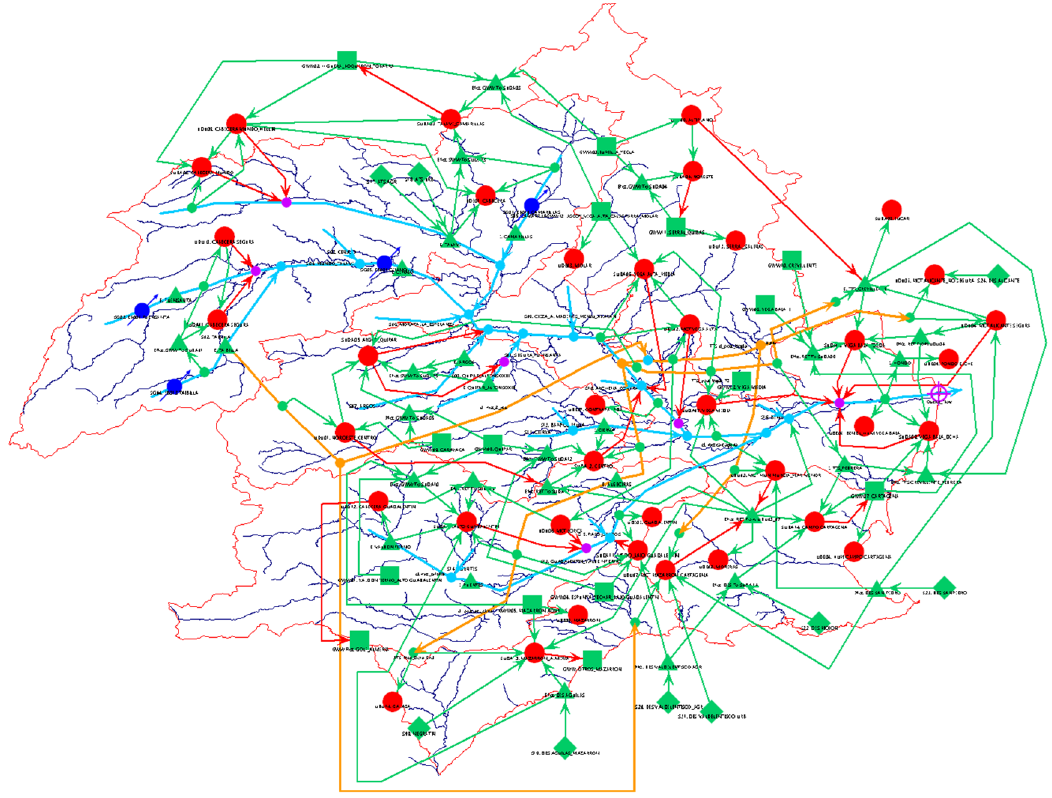
Figure A1. Water resources system model WEAP (Water Resources and Evaluation Planning) developed for the Segura river basin.